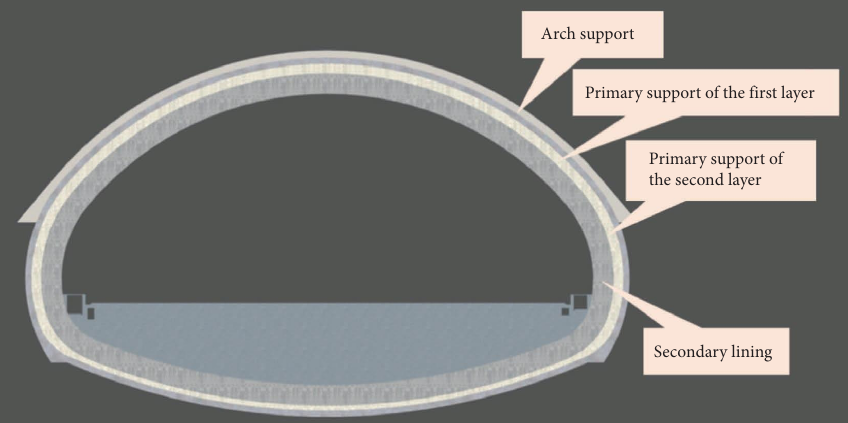
Figure 14: Structural diagram of three-layer initial support lining in long-span